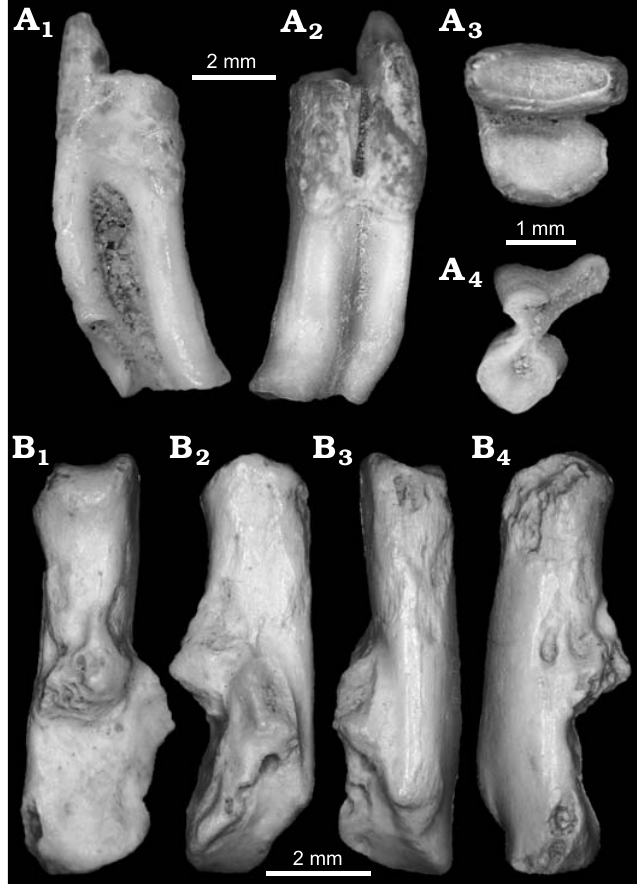
Fig. 7. Lagomorph Strenulagus solaris Lopatin and Averianov, 2006 from the Eocene of Wulanhuxiu, Nei Mongol, China. A . Right m1 (IVPP V20256.1) in lingual (A 1 ), buccal (A 2 ), occlusal (A 3 ), and apical (A 4 ) views. B . Left calcaneus (IVPP V20256.2) in dorsal (B 1 ), medial (B 2 ), plantar (B 3 ), and lateral (B 4 )